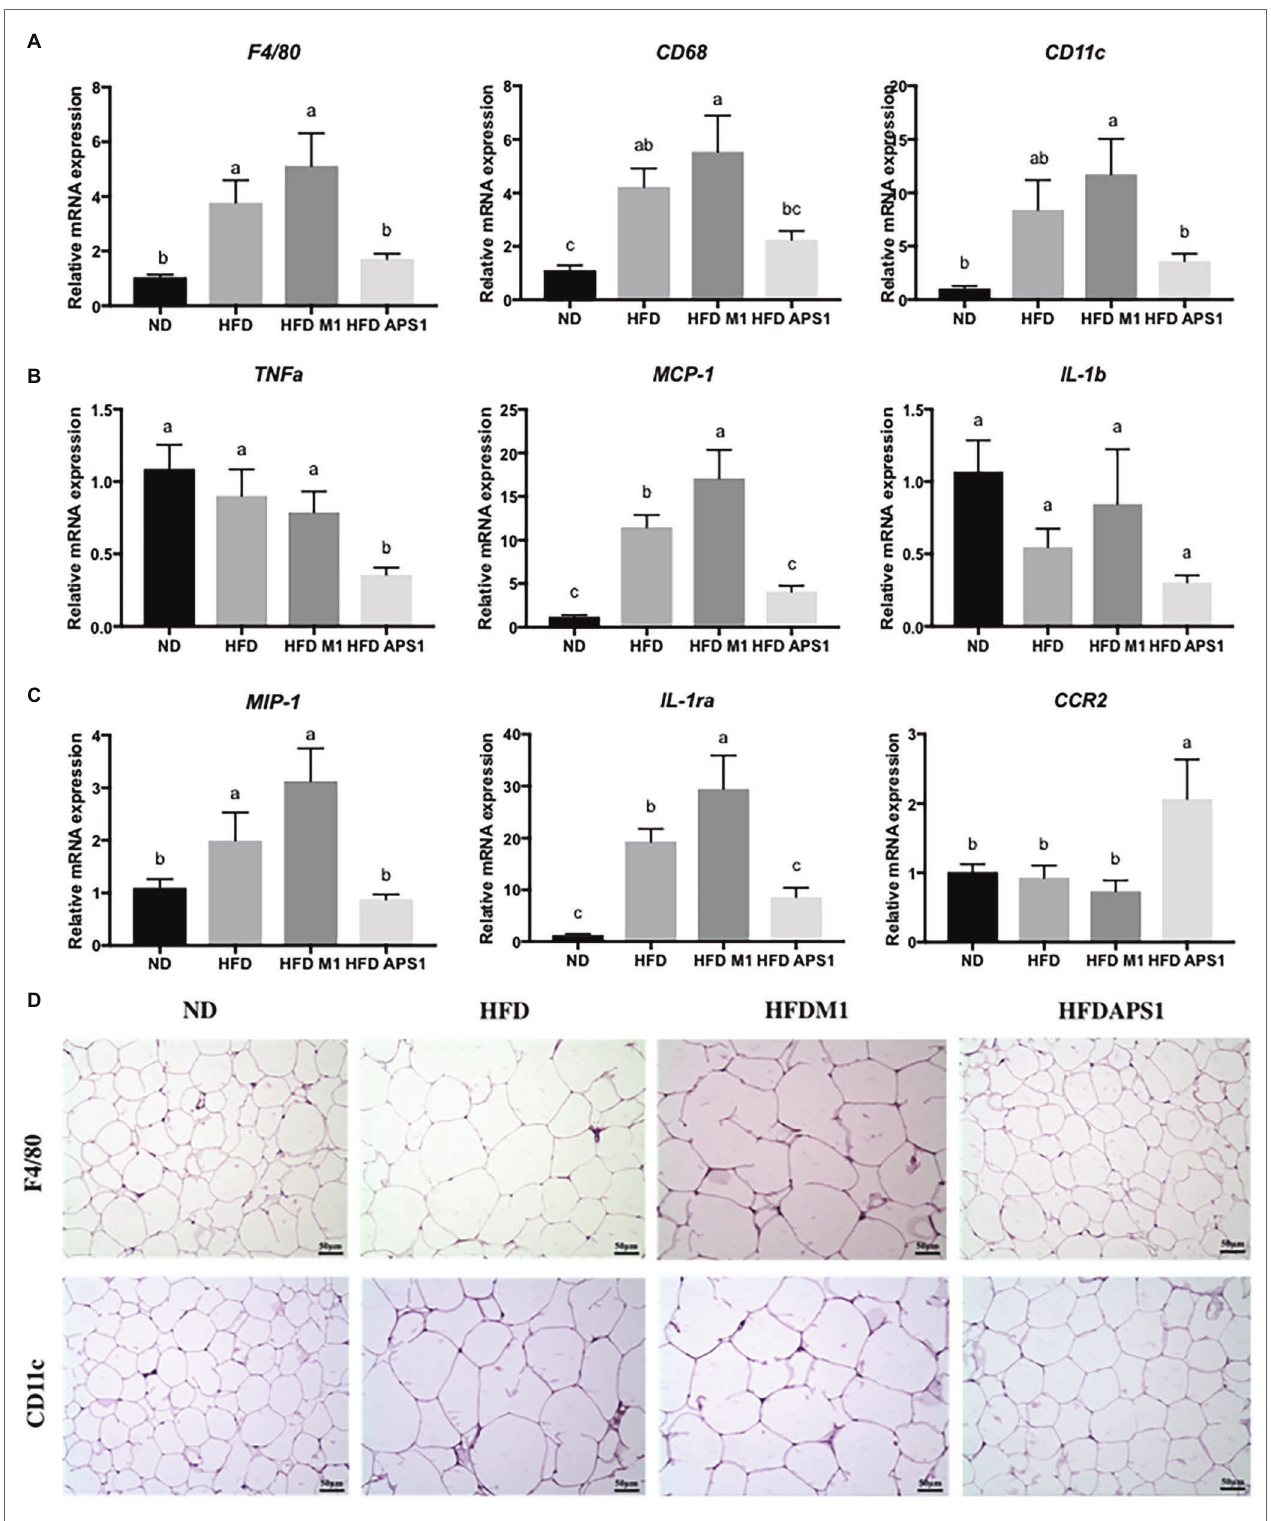
FIGURE 3 | Effects of M1 and APS1 on expression of (A) macrophage markers; (B) inflammatory markers; (C) M1‐ and M2-activated macrophages and (D) immunohistochemistry (IHC) analysis of F4/80 and CD11c in adipose tissues of high-fat diet (HFD)-induced obese mice. Relative quantification of gene expressions was performed using the comparative Ct method with normalization to GAPDH. Results were expressed as fold difference relative to a relevant control sample. Data are expressed as the mean ± SEM of 8–10 mice per group. Labeled means without a common superscript letter differ, p <